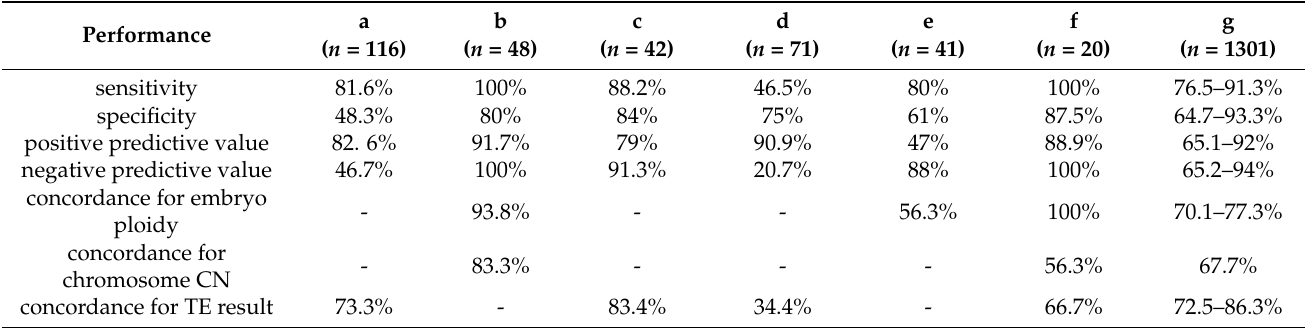
Table 3. Comparative summary result of NIPGS studies using SCM, (a) Yeung et al., (b) Huang et al., (c) Xu et al., (d) Vera-Rodriguez et al., (e) Ho et al., (f) Shitara et al., (g) Rubio et al.